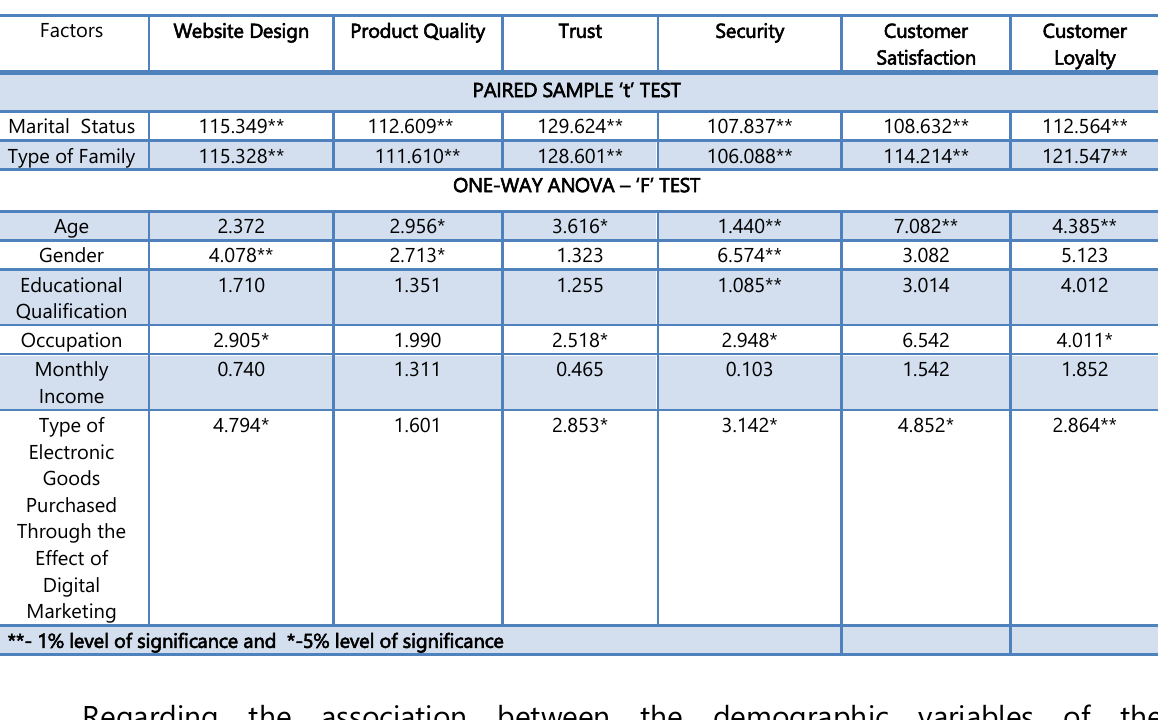
Table 6: Association between the Demographic Variables and the Factors Considered Under Digital Marketing and the Customer Loyalty (Source: Authors‟